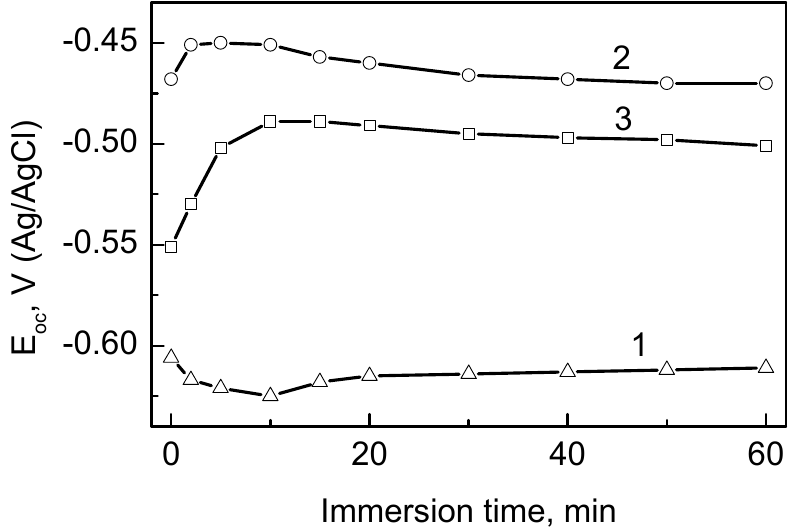
Figure 1. Variation of open circuit potential ( E oc ) of: 1—steel electrode in a solution of 0.15 M H 3 PO 4 + 0.003 M H 2 C 2 O 4 + 0.02 M NaNO 3 + 0.1 M Na 2 MoO 4 ; and Fe/P-Mo electrodes in solutions: 2—0.05 M Ce(NO 3 ) 3 ; 3—0.05 M Ce(NO 3 ) 3 + 0.025 M Na 2 SO 4 .